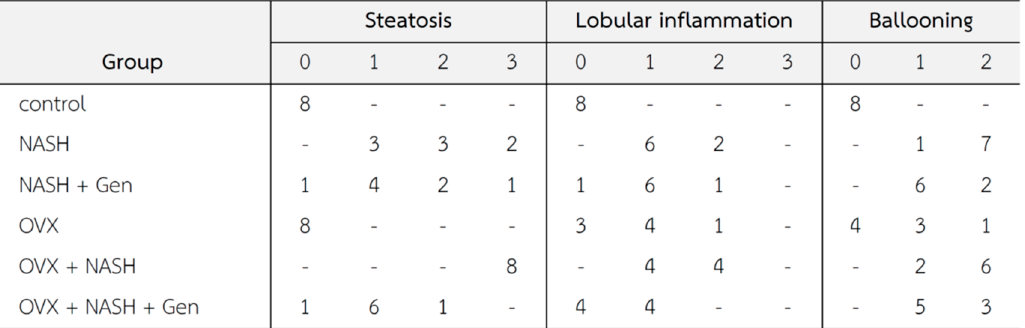
Figure 3. Changes in liver tissue ( n = 8 in each group). Criteria of histopathological scores are as fellows [3]; Steatosis: 0 = no hepatocytes containing fat; 1 ≤ 33% of the hepatocytes containing fat; 2 = 33–66% of the hepatocytes containing fat; 3 = > 66% of the hepatocytes containing fat; Ballooning: 0 = no ballooning; 1 = few ballooning; 2 = many ballooning; Lobular inflammation: 0 = no inflammation and necrosis; 1 = mild zone 3 injury/inflammation; 2 = noticeable zone 3 inju- ry/inflammation; 3 = severe zone 3 injury/inflammation.